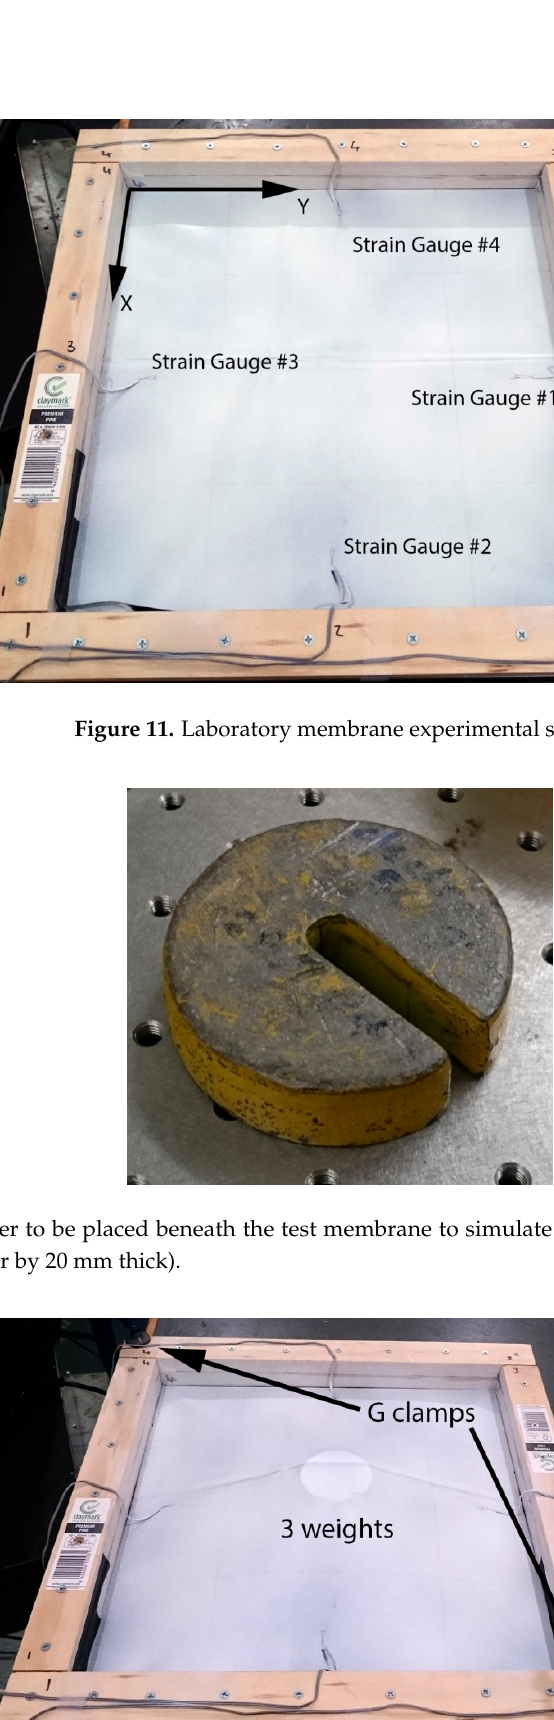
Figure 13. Test membrane with three spacers (simulated scum-berg) placed under the membrane.